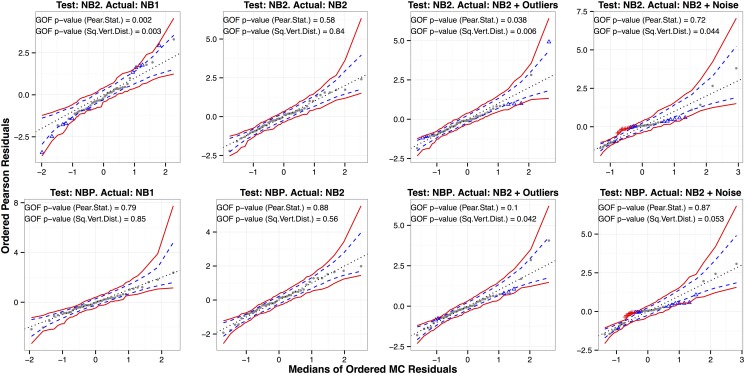
Empirical probability plots and GOF p-values for testing NB2 (top row) and NBP (bottom) on four simulated datasets with sample size = 45.The simulated response distributions are (left to right): NB1, NB2, NB2 with outliers and NB2 with random (0, 22) noise added to log(ϕ). We superimpose 95% prediction envelopes in dashed blue lines and 95% simultaneous prediction bands in solid red lines (based on 999 Monte Carlo simulations). Points outside the prediction envelope but inside the simultaneous confidence bands are flagged as blue triangles, and points outside the simultaneous confidence bands are flagged as red crosses.